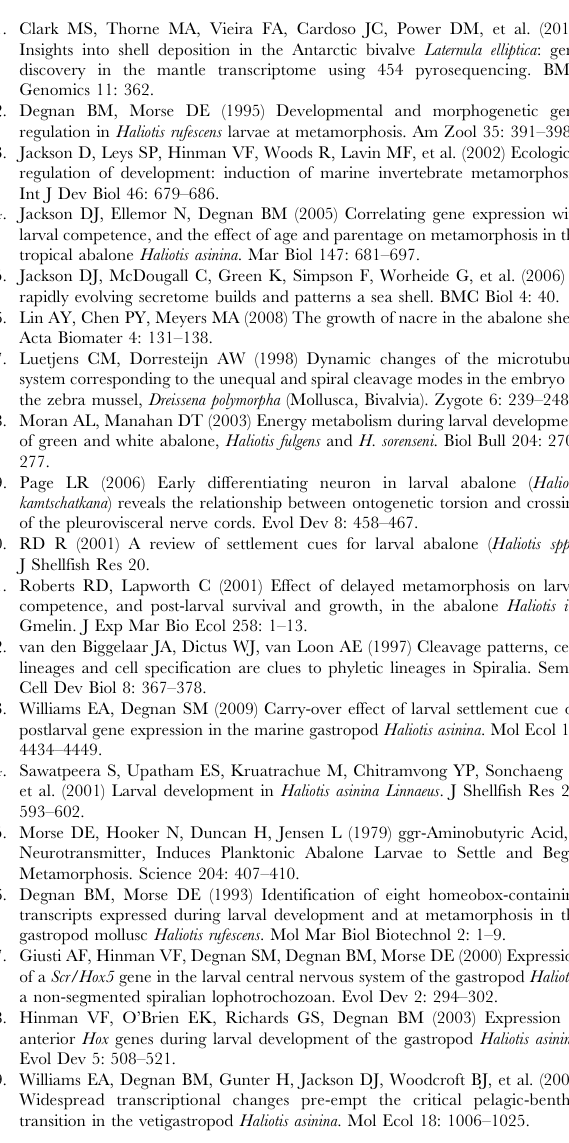
Table S1 Information for the GO annotations of the unigenes. (XLS) Table S2 Expression data of the 1491 genes with total physical counts larger than 16.